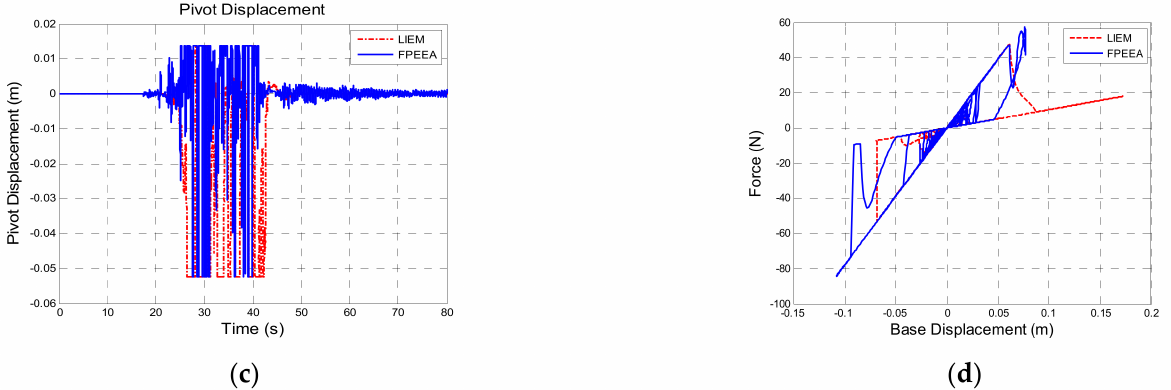
Figure 12. Comparison for the FPEEA and LIEM controls (TCU102, PGA = 0.1 g). ( a ) Isolation layer displacement.